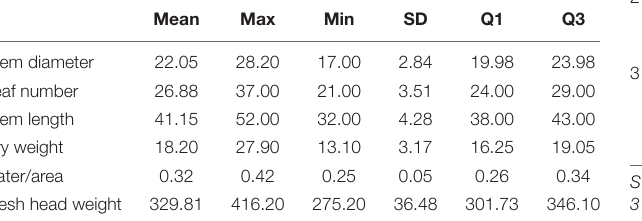
TABLE 1 | Descriptive statistical analysis of the collected data.